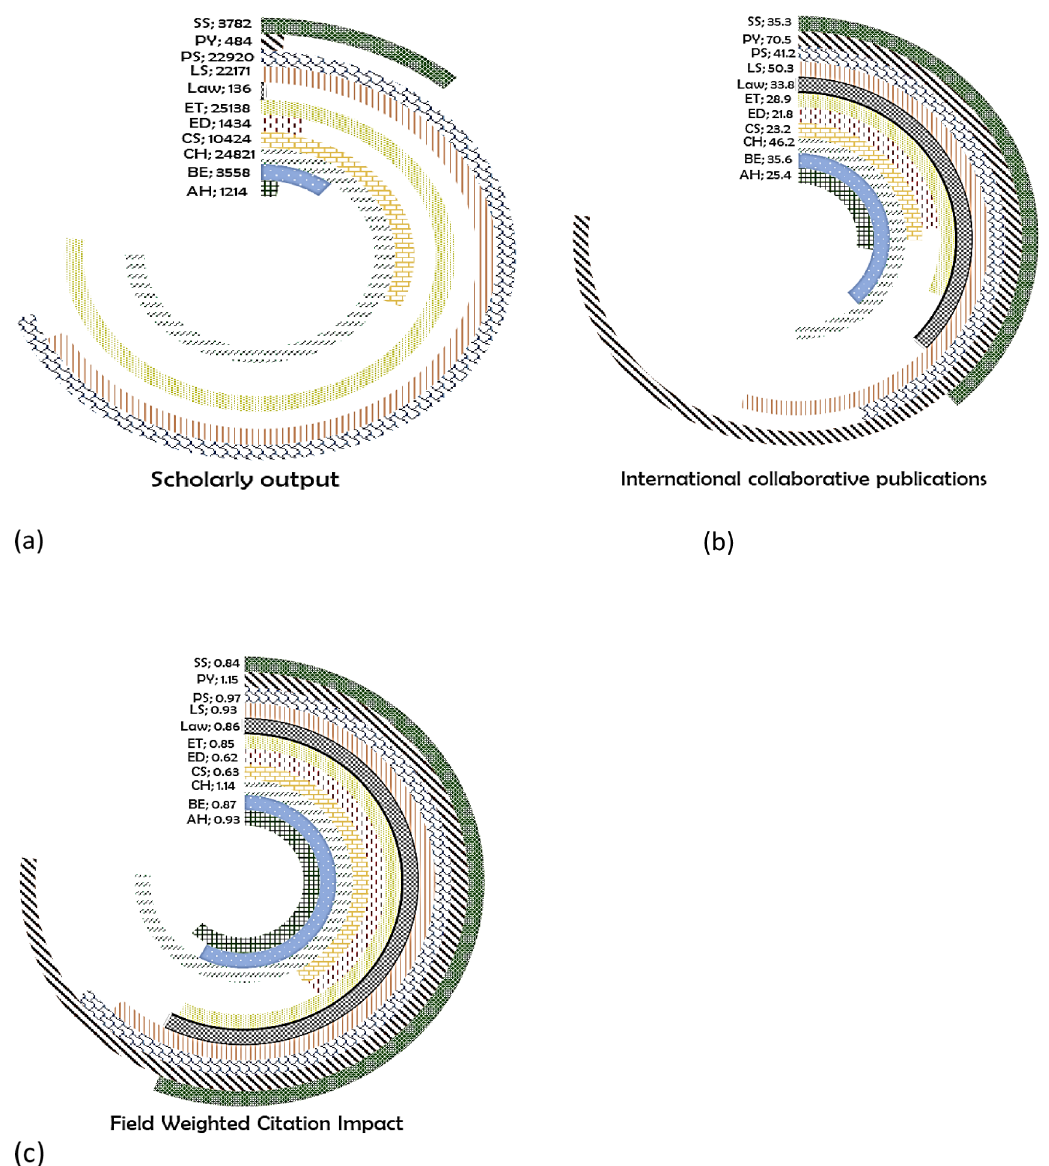
Figure15.SubjectwisesplitofThailandresearchoutcome(a)scholarlyoutput,(b)Internationalcollaboration and (c) FWCI. Arts &Humanities (AH),Business and Economics (BE), Clinical, pre-clinical and health (CH), Computer Science (CS), Education (ED), Engineering and Technology (ET), Life Science (LS), Physical Science (PS), Psychology (PY), Social Science